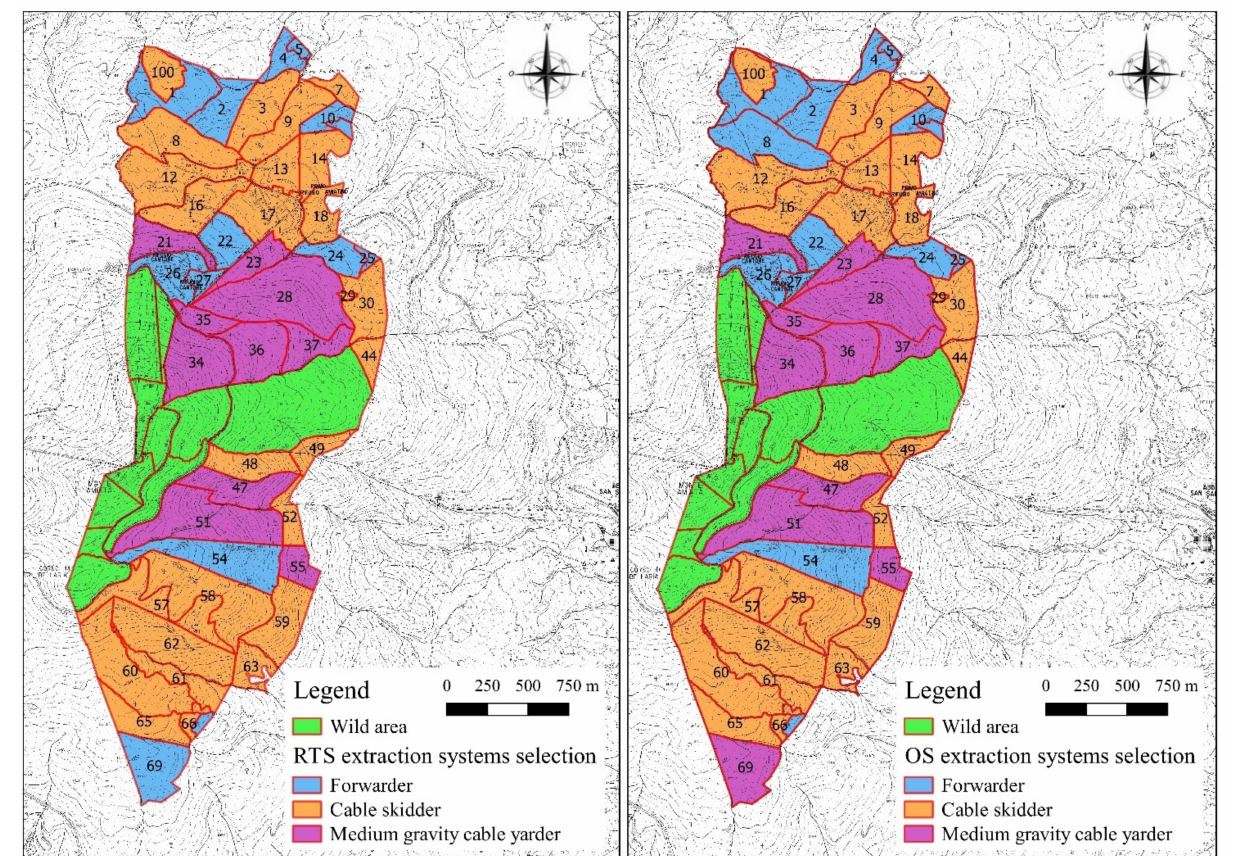
Figure 5. RTS extraction method selection (on the left ) and OTS (on the right ). As shown, the two predictions differ only for two sub-compartments (no. 8 and no. 69). In sub-compartment 8 (northwest of the study area), RTS indicated the cable skidder as an option, while OS selected the forwarder. In sub-compartment 69 (south of the study area), RTS selected the forwarder while OS the cable